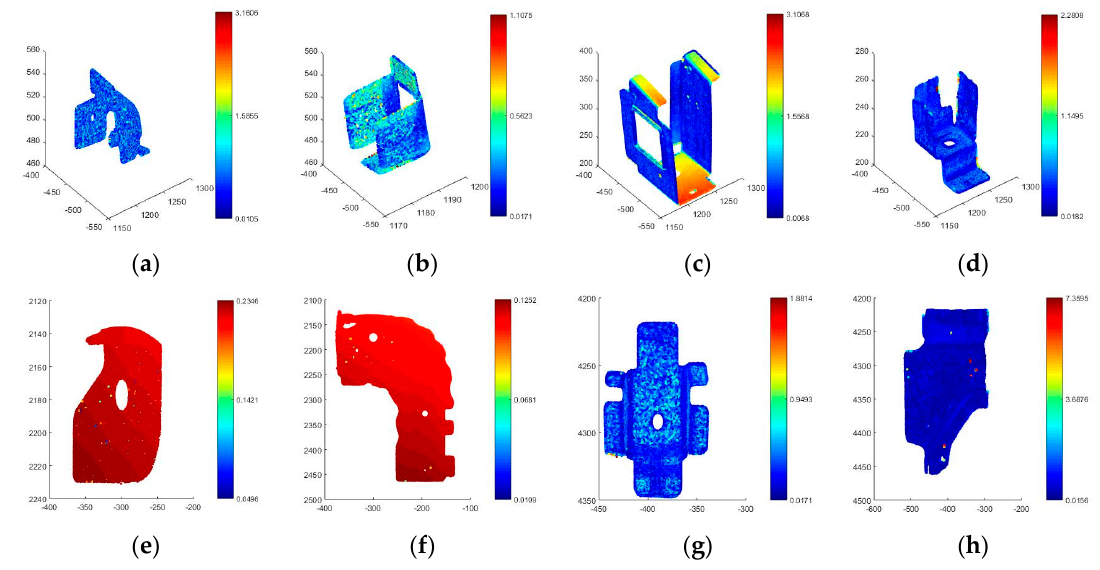
Figure 18. The color deviation diagram of inspection results in Figure 3. ( a )–( h ) are a series of inspection results color deviation diagram of vehicle body parts in Figure 3, respectively.